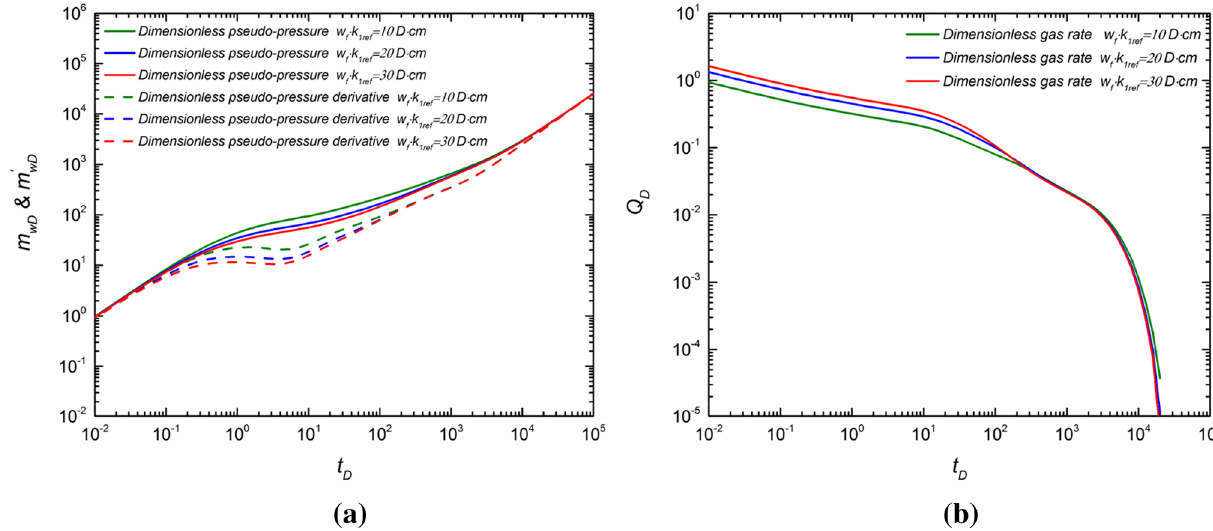
Fig. 10 Effect of fracture conductivity on pseudo-pressure and rate curves. a Dimensionless pseudo-pressure and pseudo-pressure derivative curve, b dimensionless rate